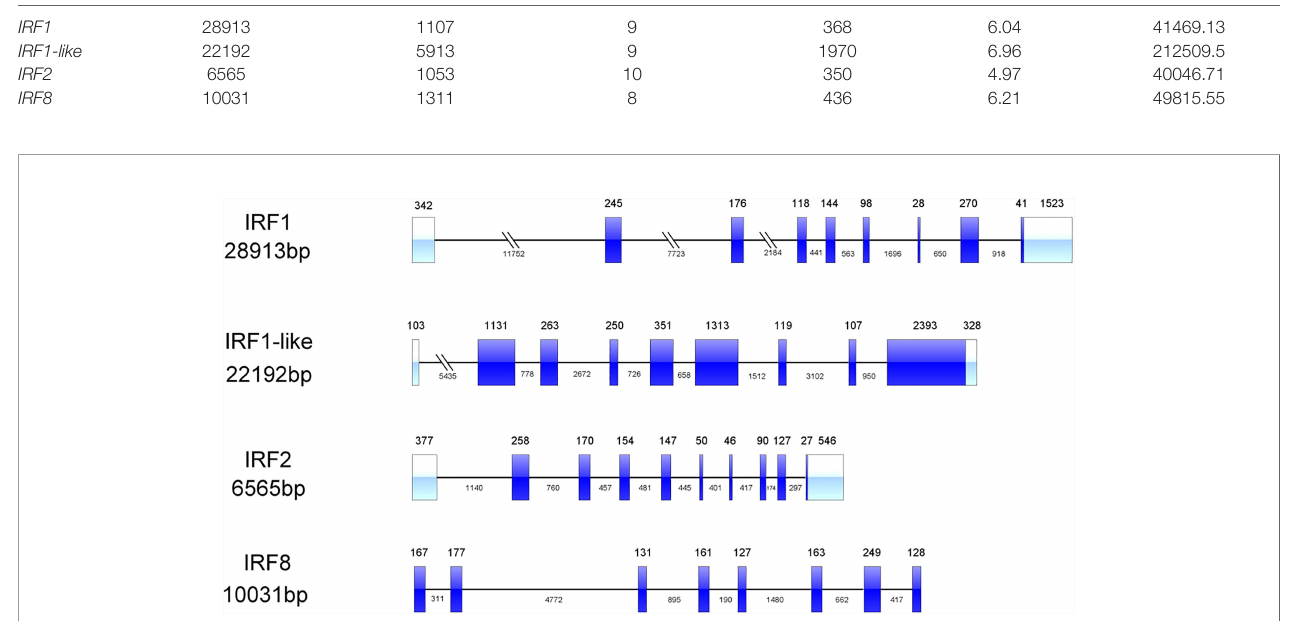
FIGURE 1 | Genetic structure of the CfIRF genes. The light blue boxes indicate the 3 ’ UTRs and the 5 ’ UTRs. The dark blue boxes indicate the exons. The horizontal line with sporadic double slash indicates the